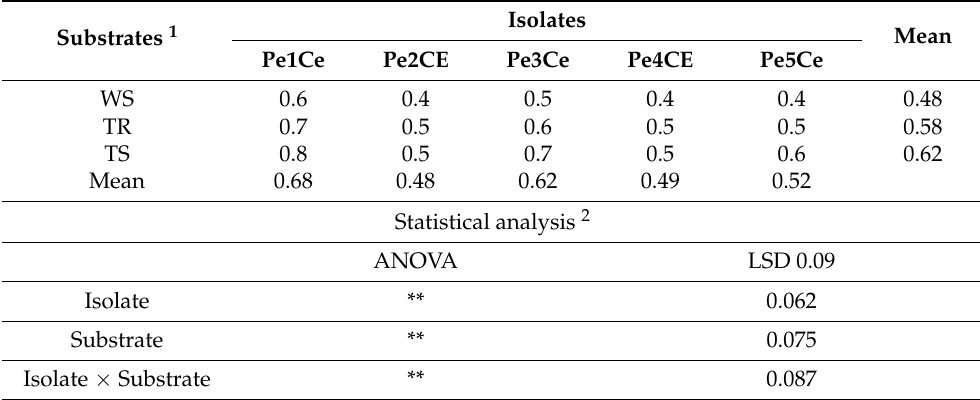
Table 2. Speed growth expressed in mm day − 1 of the isolates Pe1Ce to Pe5Ce grown on the media. Substrates